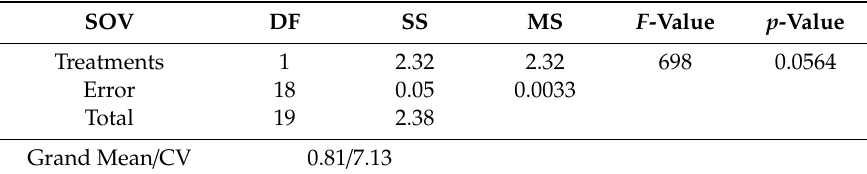
Table A16. Influence on the total amount of dry weight per plant (g) of PeBL1-treated, and control cucumber